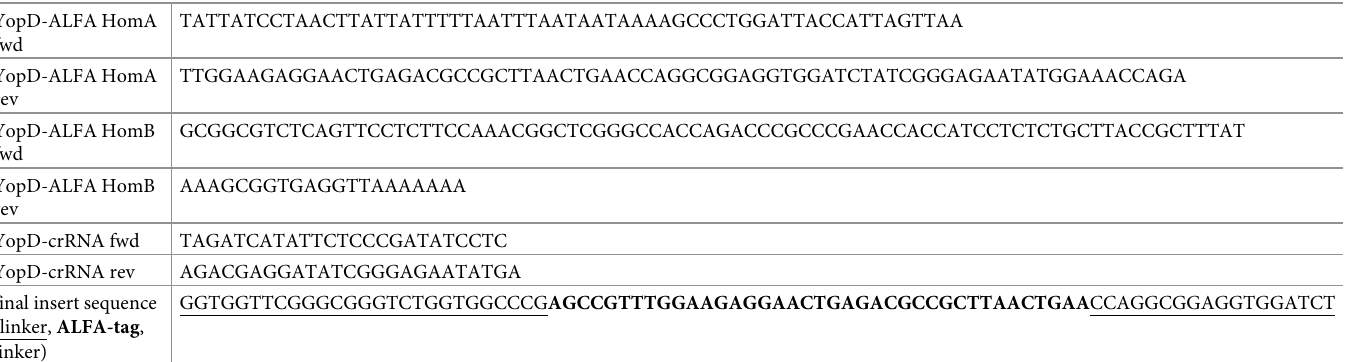
Table 2. Oligonucleotides and